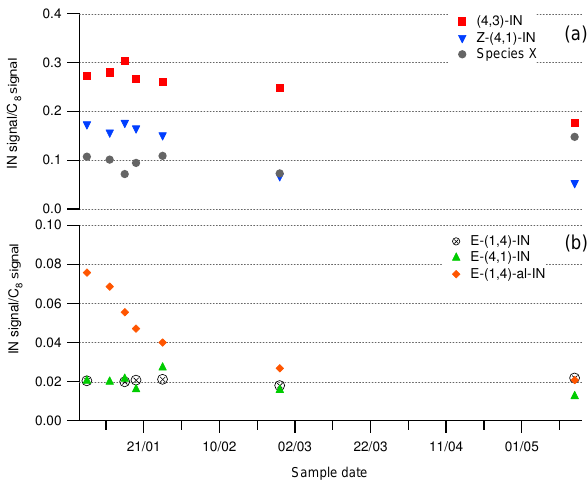
Figure 6. Ratios of INs to a stable C 8 alkyl nitrate in a temperature- controlled, fan-mixed 100L aluminium drum measured over a pe- riod of 4 months using the Tenax trapping method described in Sect. 4. The drum contents were left for 3 weeks to equilibrate be- fore the first